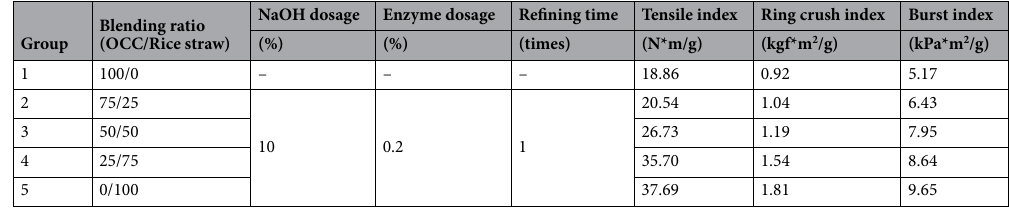
Table 7. The handsheet physical properties after the best refining time conditions.